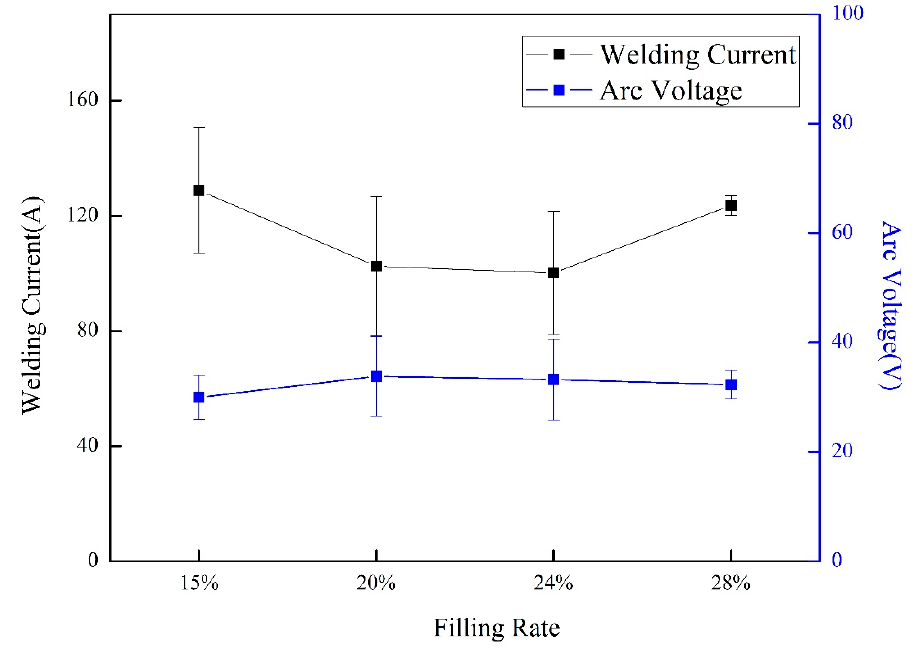
Figure 3. Effect of filling rate on average welding current.